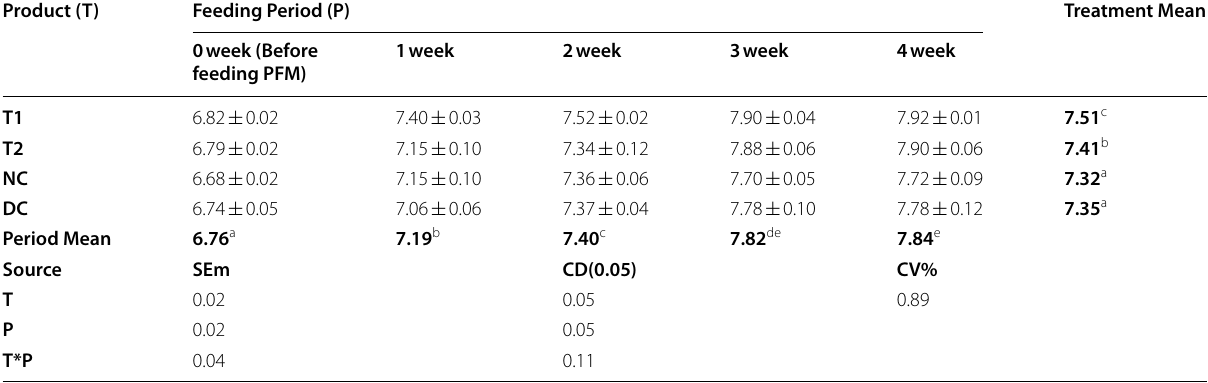
PFM Probiotic fermented milk